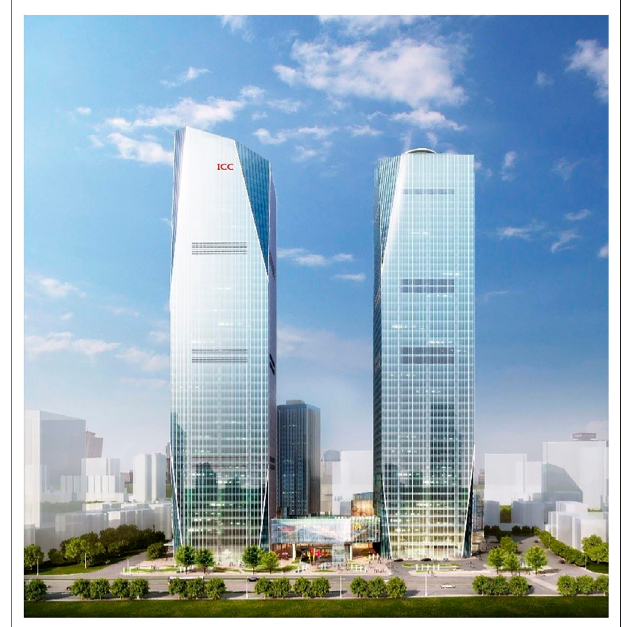
FIGURE 3 | Front drawing of the WHICC in